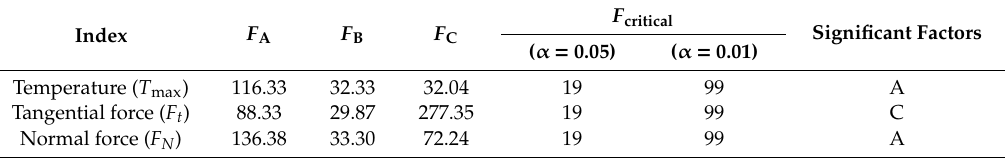
Table 4. Variance analysis of measured grinding temperature, tangential force, and normal force.